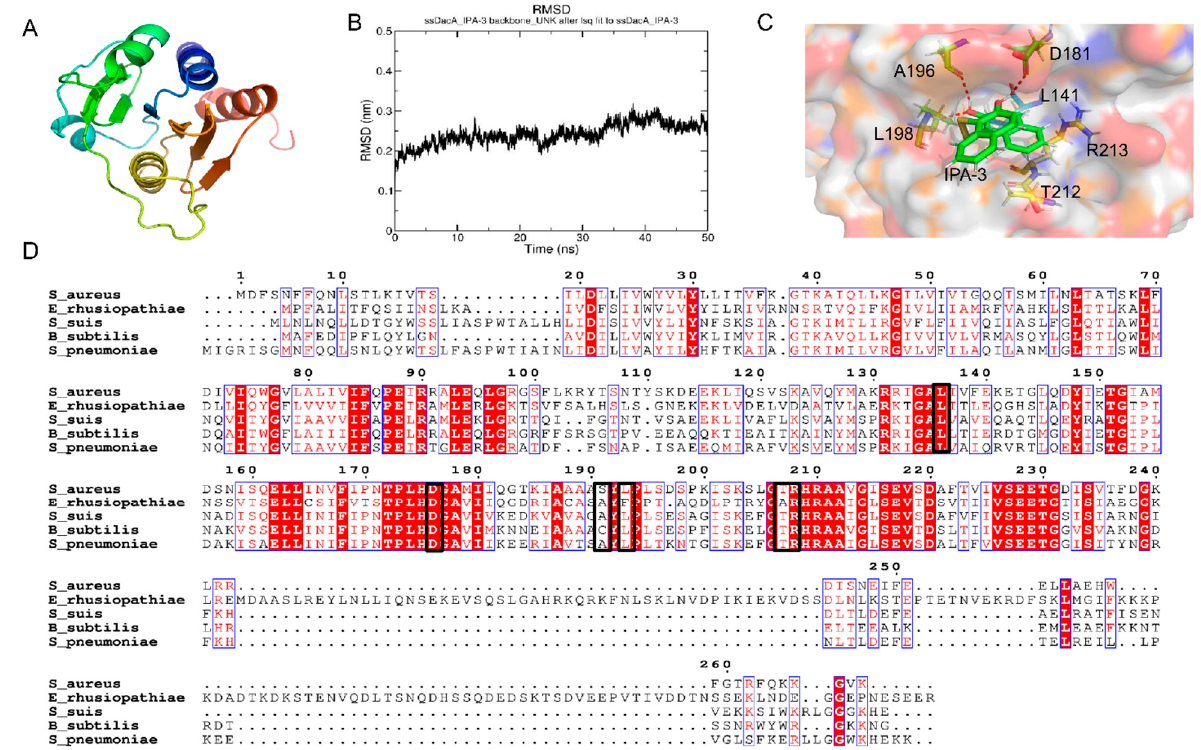
Figure 5. Analysis of the binding mode between IPA-3 and ssDacA. ( A ) The simulated 3D structure of ssDacA. The amino acid sequence of ssDacA was analyzed using the I-TASSER server. The image was generated by PyMOL software. ( B ) RMSD plot. The IPA-3 was docked to the simulated structure of ssDacA by using Autodock4 software and a molecular dynamics simulation was performed to further optimize the binding conformation using GROMACS software (2021 version), which generated the RMSD plot. ( C ) Optimized binding model between IPA-3 and ssDacA. The optimized conformation was taken from the stable and equilibrious time point in the molecular dynamics simulation. The protein–ligand 3D structure was generated using PyMOL software, where the green structure represents IPA-3 and the other structures represent the residues within the binding pocket of ssDacA. ( D ) Multiple sequence alignment of diadenylate cyclase from different bacteria. Multiple sequence alignment was generated by using MEGA version 6 software and the ESPript 3.0 server based on the amino acid sequence of diadenylate cyclase from each indicated bacterium. The amino acids involved in the interaction are shown in the black boxes.